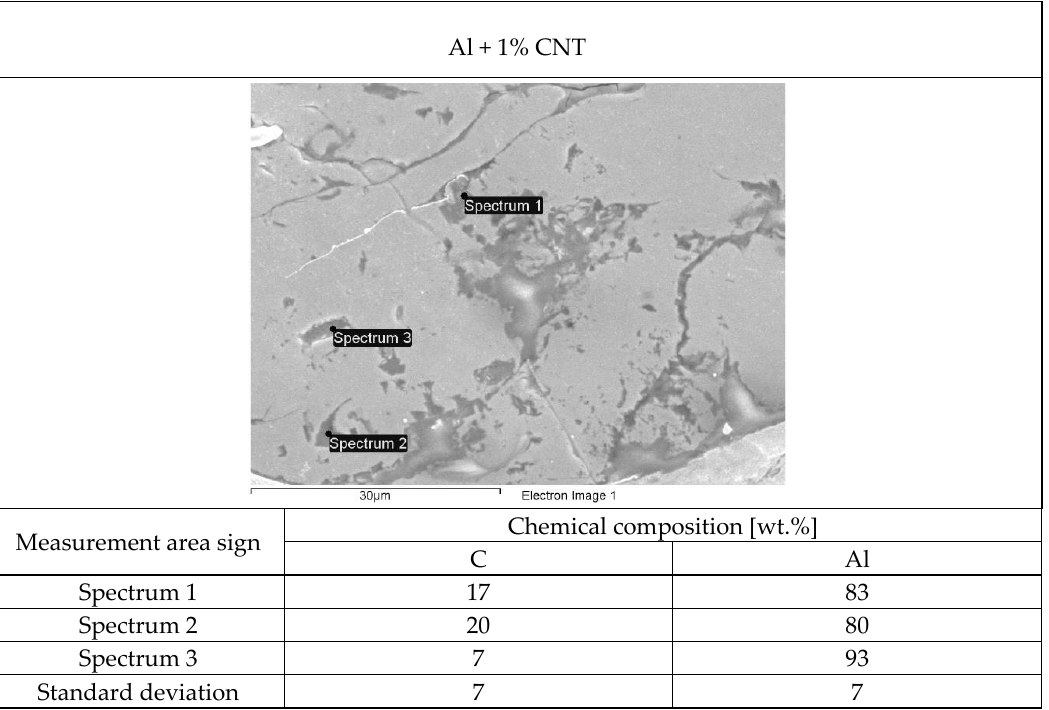
Figure 8. The structure of aluminum powder with 1 wt.% Nanocyl NC 7000 carbon nanotubes flame-sprayed coating with marked chemical composition tested areas on SEM.